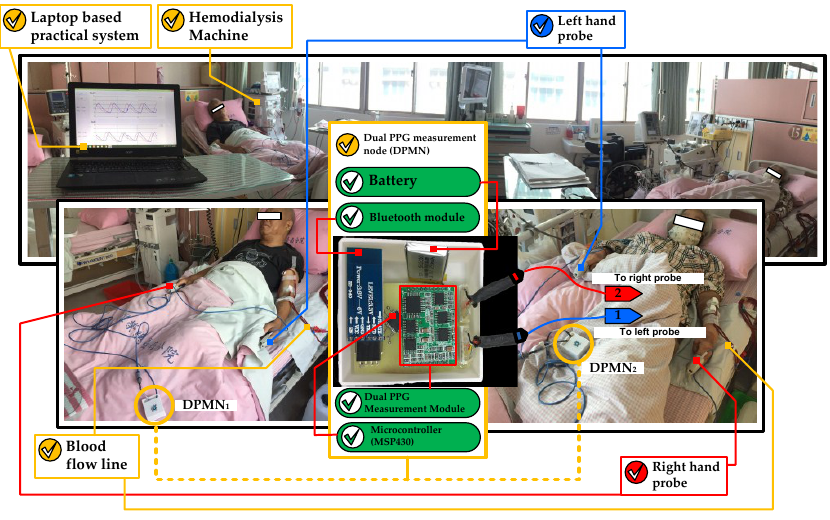
Figure 6. The dual optical PPG system implemented on the patients.